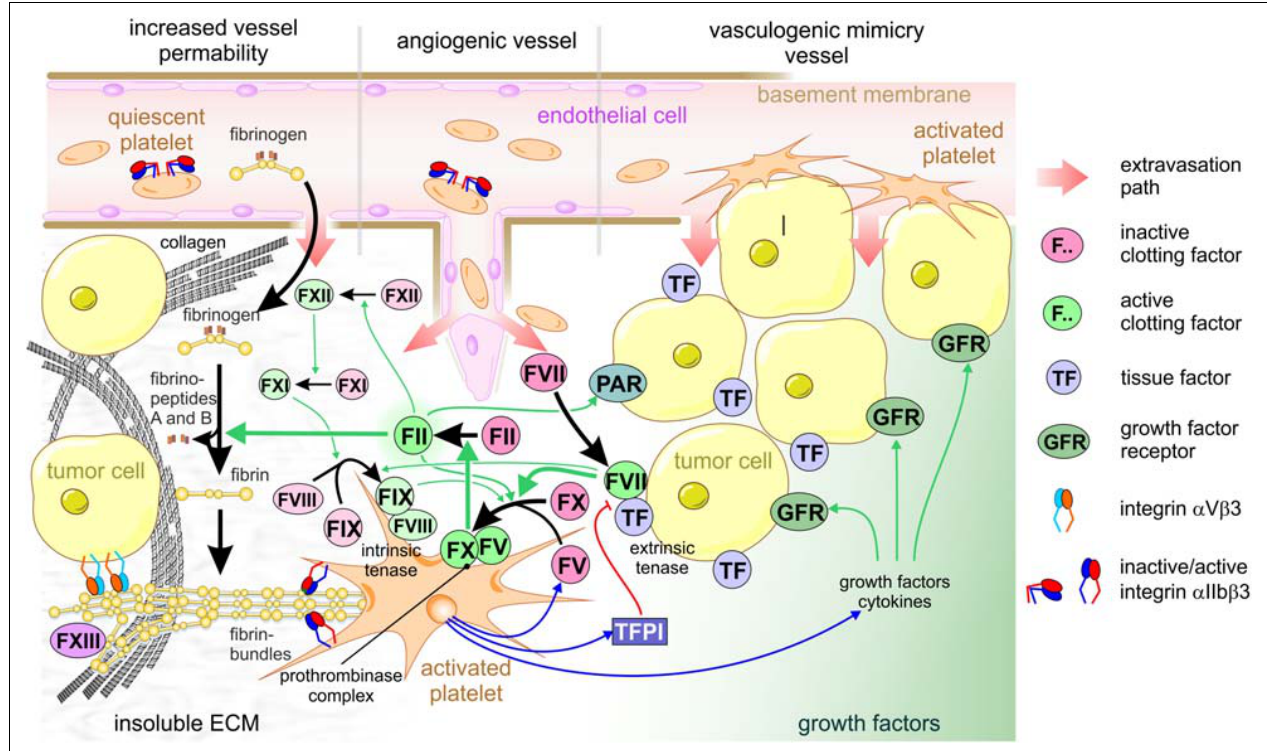
FIGURE 2 | Platelets are crucial for tumor cell-induced coagulation and contribute to the TME of solid tumors. Increased vessel permeability in the vicinity of a tumor, tumor-induced angiogenic sprouting or vasculogenic mimicry vessels are three ways that allow extravasation of platelets and clotting factors from the blood stream into the interstitial stroma of tumor tissue. After the platelets recognize vWF of the subendothelial basement membrane, or collagen of the desmoplastic TME, platelets become activated, thereby take a dendritic shape, expose phosphatidylserine on the outer leaflet of cell membrane, degranulate, and activate the adhesion receptors, especially α IIb β 3 integrin. After leaking from the blood vessel, clotting factor VII immediately is activated and associates with tissue factor, which is abundant on most tumor cells, thereby forming the extrinsic tenase complex. This activates factor X and XI, the former of which forms the prothrombinase complex, together with platelet-secreted factor V, on the surface of activated platelets exposing phosphatidylserine. This activates thrombin (factor II). In addition to this main activation path, thrombin activation is perpetuated by integrating the intrinsic coagulation pathway: thrombin > factor XII > factor XI > intrinsic tenase complex (factor IX:FVIII) > factor X > thrombin. Also, PARs are activated by thrombin on tumor cells, additionally promoting tumor progression. Activated thrombin converts soluble fibrinogen from the blood plasma to insoluble fibrin molecules that aggregate into highly ordered fibrin bundles. They change the composition of the TME substantially and allow further platelets to adhere. Activated platelets secrete not only factor V and factor VIII, but also tissue factor pathway inhibitor (TFPI), thereby feeding back on the extrinsic tenase complex, as well as growth factors. Relevant growth factor receptors, e.g., for PDGF and TGF β , provide proliferative signals to tumor